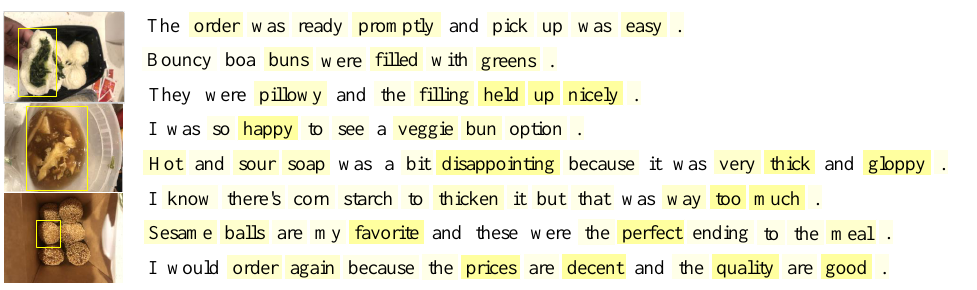
Figure 6. A review from a Chinese restaurant in San Francisco from Yelp.com with a rating of 4. The color depth represents the weight proportional to the importance of the